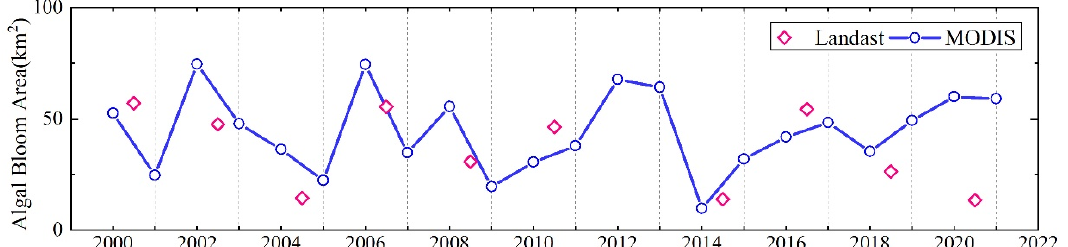
Figure 10. Comparison of the algal bloom area between Landsat (every 2 years) and MODIS/Terra from 2000 to 2021.